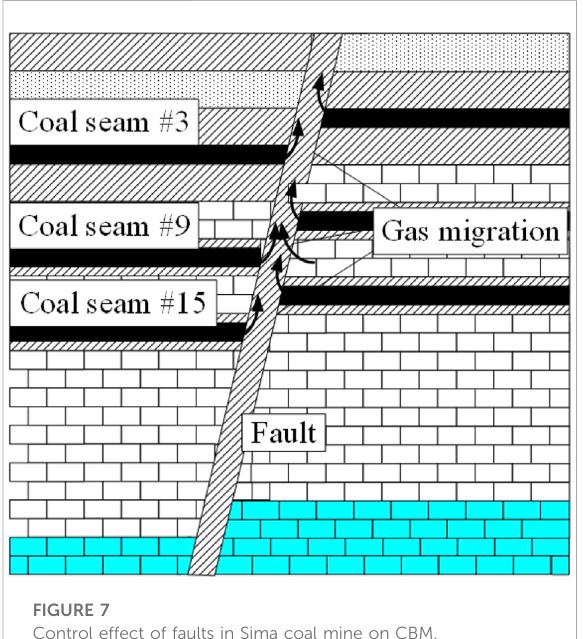
FIGURE 7 Control effect of faults in Sima coal mine on CBM.